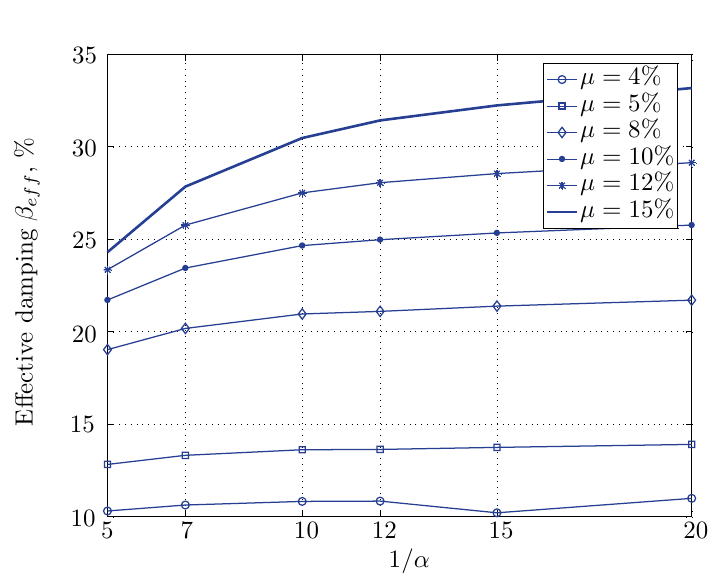
Figure 20. Effective damping for various isolation system parameters